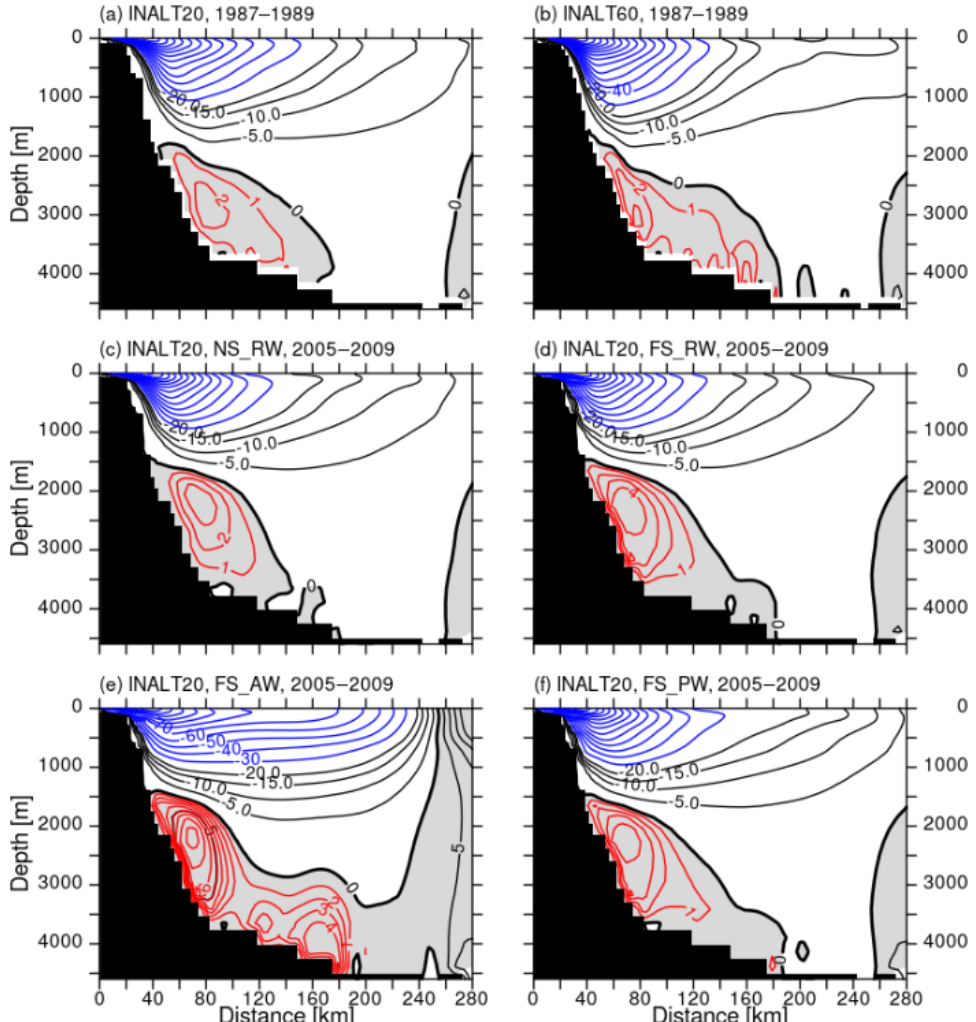
Figure 14. As Fig. 13 but (a) INALT20 and (b) INALT60, averaged over years 8 to 10 (1987–1989) of the spin-up experiments and for the sensitivity experiments in INALT20 averaged over the period 2000–2009 ( c – f